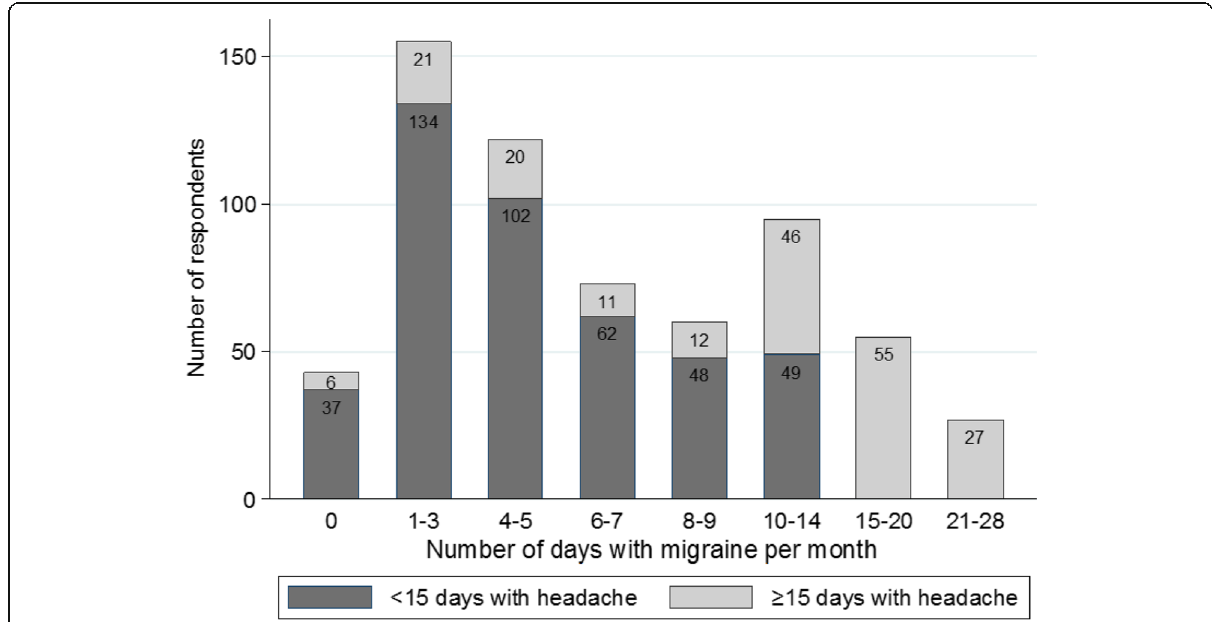
Fig. 2 Number of respondents by number of migraine days per month divided into groups with < 15 and ≥ 15 headache days per